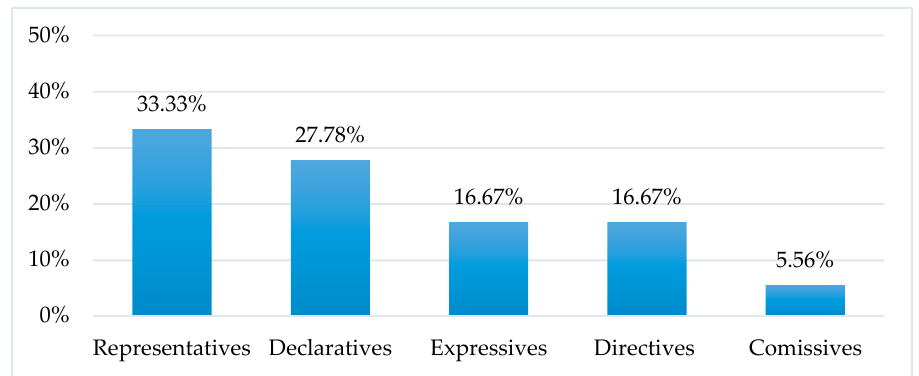
Figure 3. Evaluating the agent’s illocutionary acts.